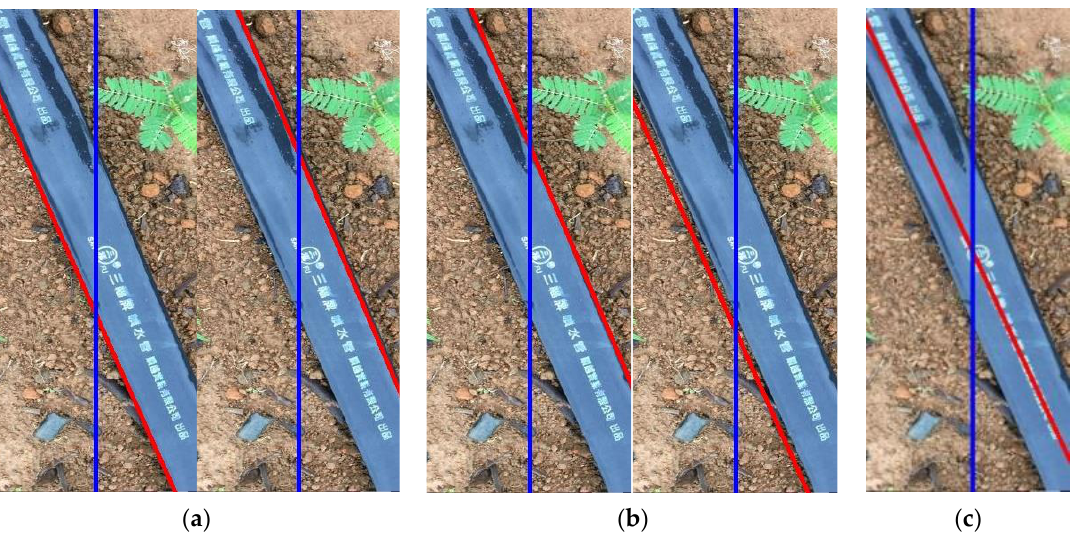
Figure 6. Results of different drip tape detection methods combined with HLT (red color): ( a ) Canny with HLT; ( b ) Laplacian with HLT; ( c ) proposed HLT. The white solid and dashed frames represented the field of view captured by the camera when the robot turned (Figure 7a). The upper and lower graphs in Figure 7b–f represented the image-processing results within the solid frame and the dashed frame, respectively. A line (Figure 7g) could be obtained by applying the HLT in Figure 7f.